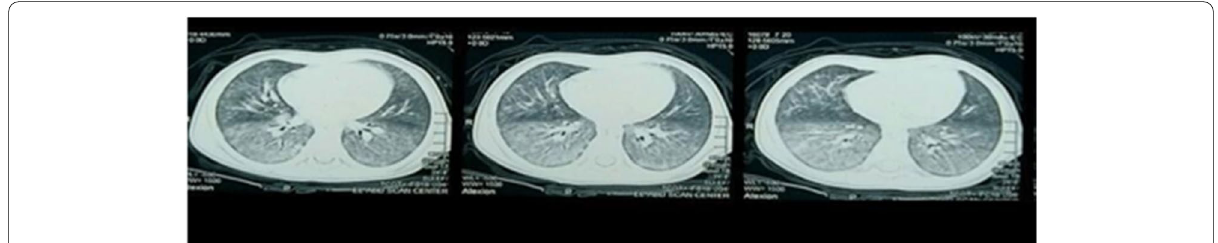
Fig. 2 Bilateral lower lobar, to less extent middle lobar diffuse ground glass attenuation, reticulonodular densities, and peribronchial thickening